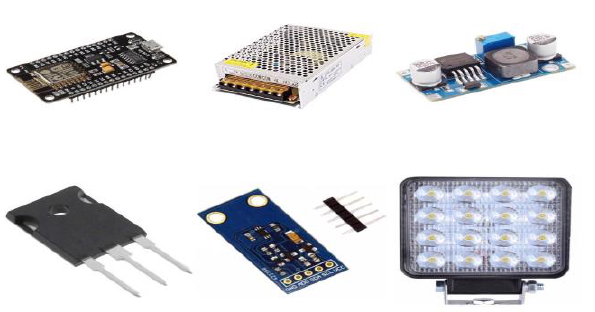
Figure 2.1. Materials Used to Keep the Ambient Light Level Constant